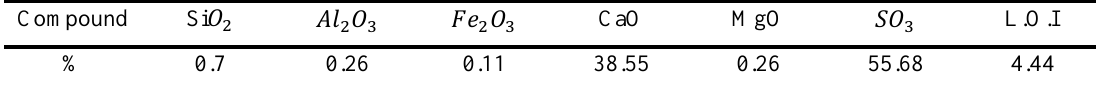
Table 3. Gypsum chemical composition